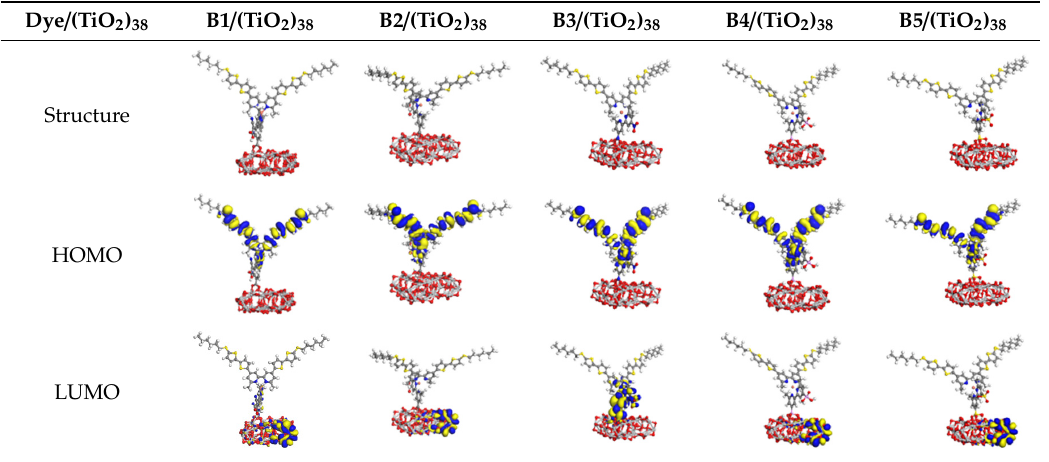
Table 3. The optimized structures and frontier molecular orbitals (with an isodensity of 0.01 au) for dye/(TiO 2 ) 38 systems.